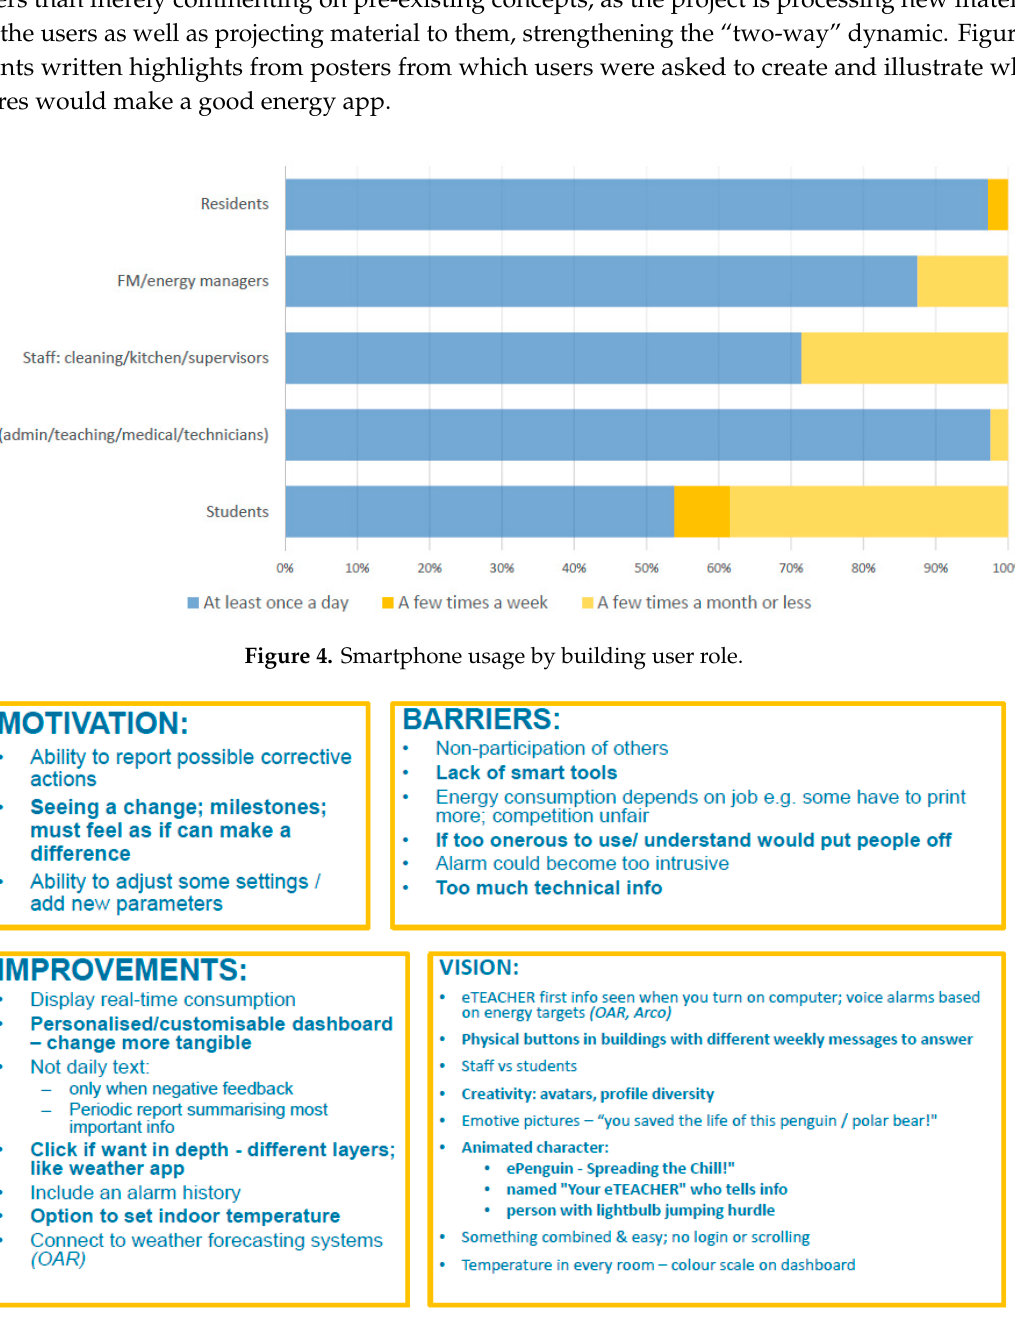
Figure 5. Highlights from posters regarding the features of a good energy app.